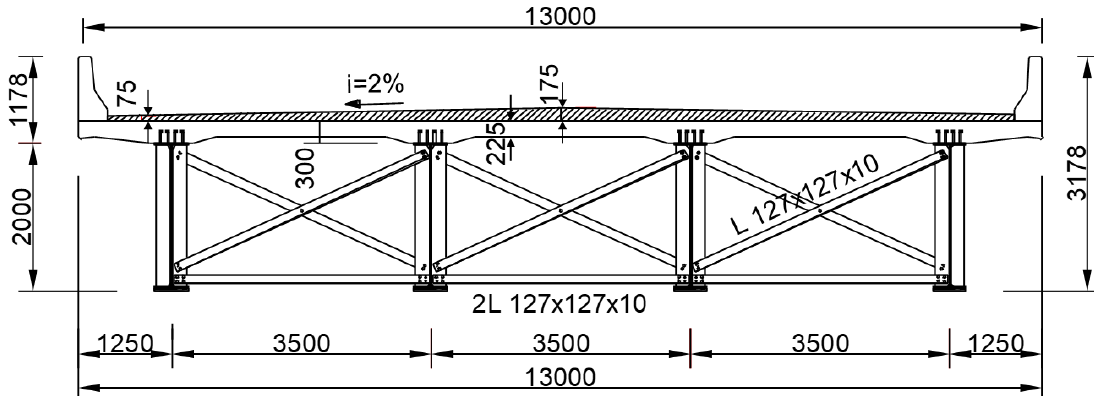
Figure 4. Bridge section at the support: units in millimetres [6].